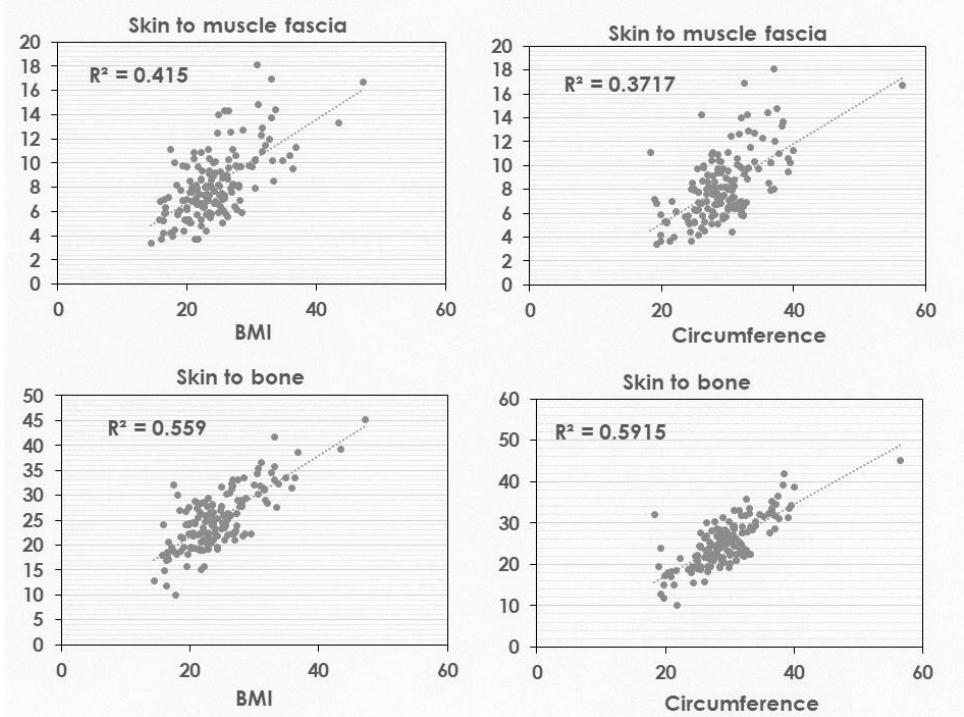
Figure 2. Correlation of BMI and circumference through the deltoid area with depth from the skin surface to muscle fascia and bone.